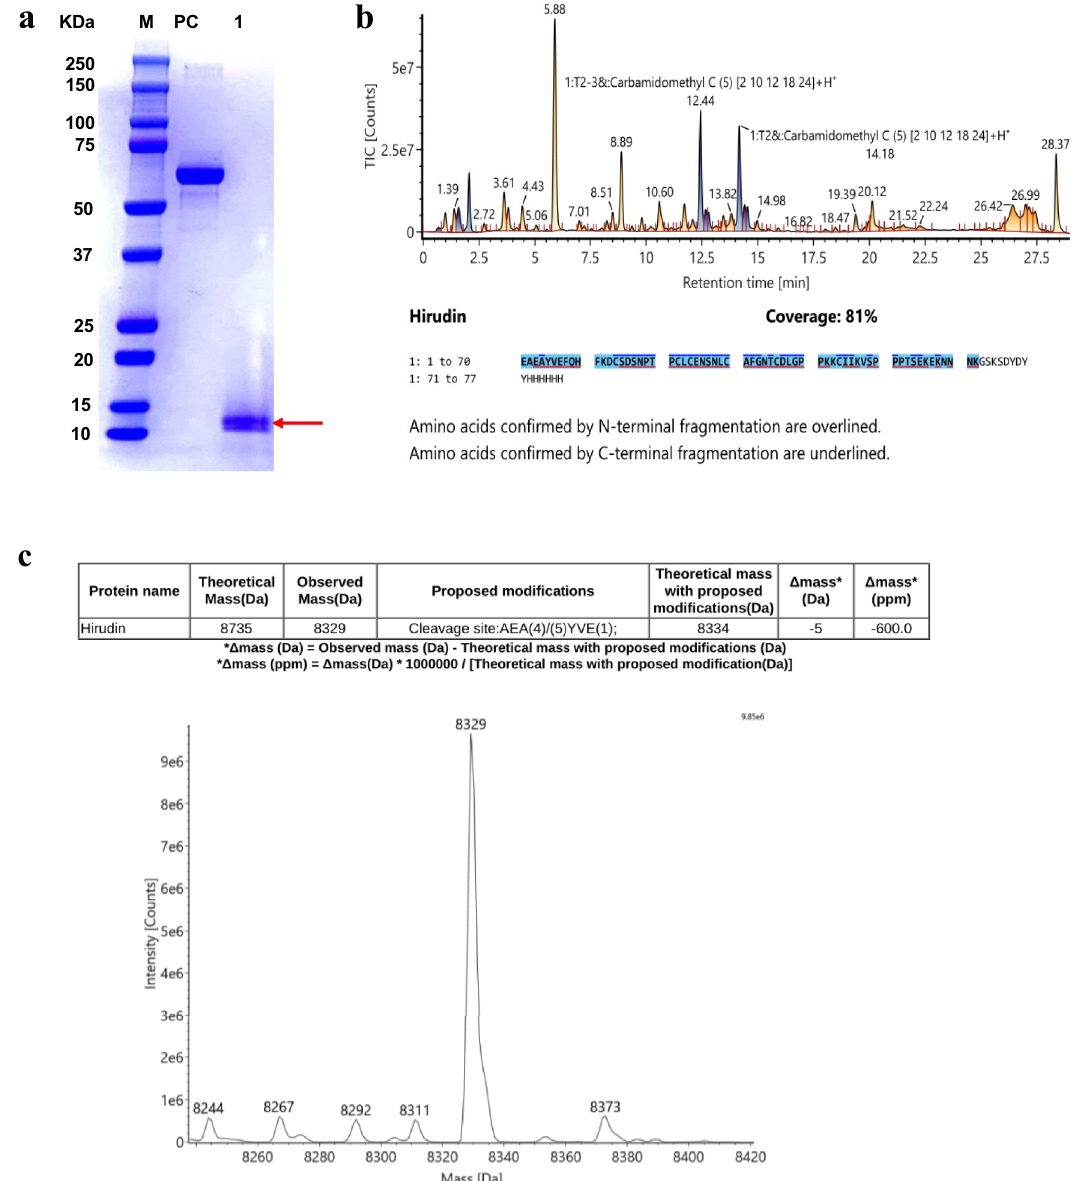
Figure 7. SDS-PAGE and mass spectrometric analysis of the purified protein. ( a ) SDS-PAGE detection of purified hirudin (M: Protein marker (Bio-rad, Cat. No. 1610374S). PC: BSA (2 µg). Lane 1: Purified hirudin.) ( b ) Tryptic digestion peptides and sequence of hirudin. ( c ) Liquid chromatography-tandem mass spectrometry detection of hirudin. The peak represents a mass of 8329 Da. Purified hirudin was analyzed on a 15% SDS- PAGE gel. The original gel is presented in Fig.